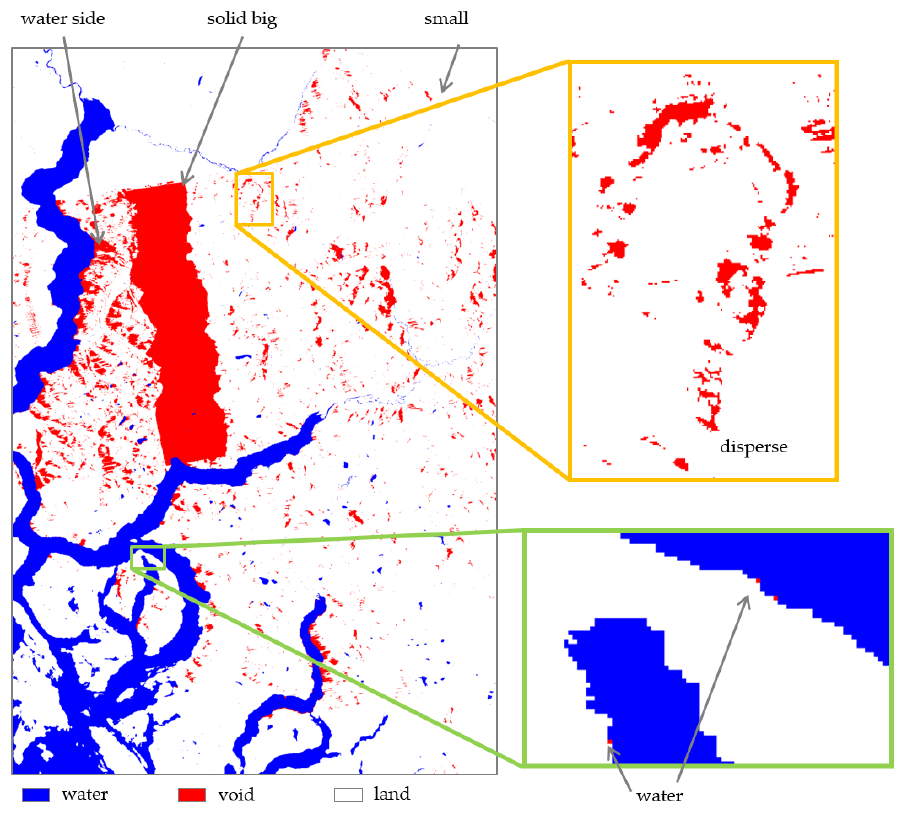
Figure 4. Segmented void water image and associated classification tags as detailed in Section